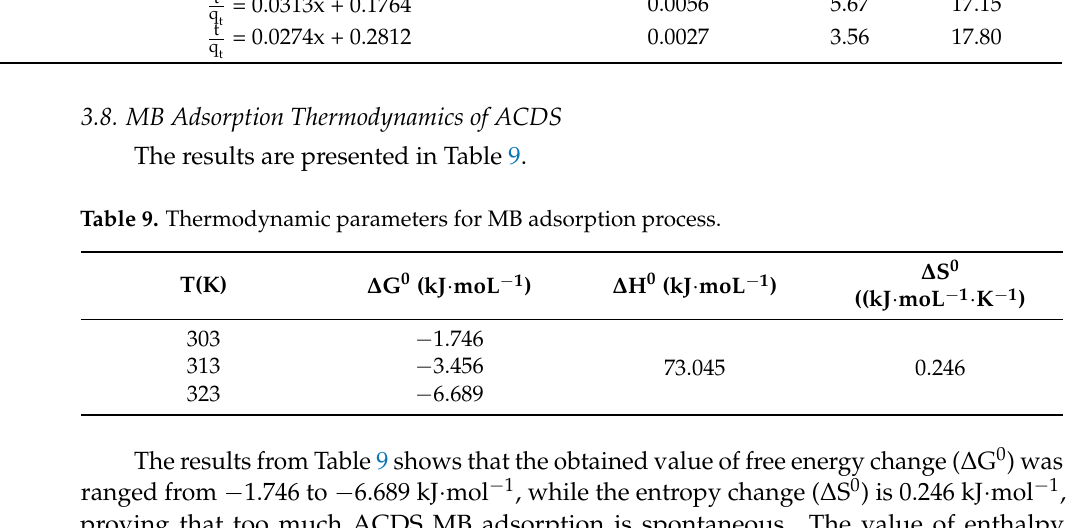
Figure 13. ( A ) The dependence of q t on time t 0.5 and ( B ) The dependence of ln(1 − F) on time.